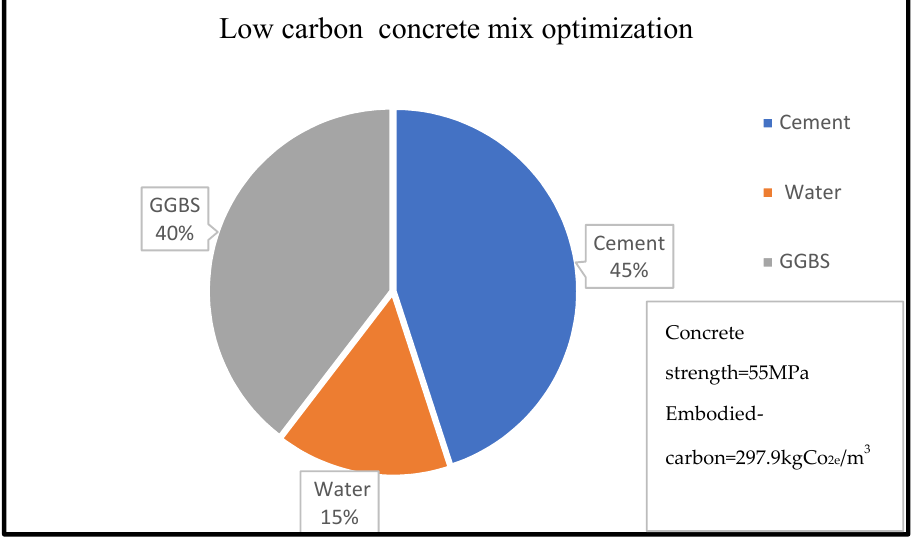
Figure 2. LCC constituent material at water content of 15% [34].